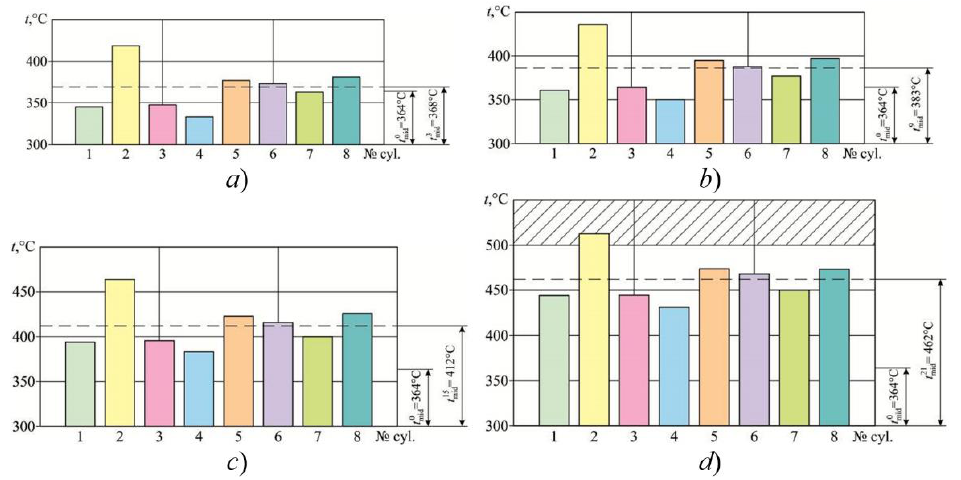
Figure 12. Change in exhaust gas temperature in the cylinders of a 16V32 STX-MAN marine diesel